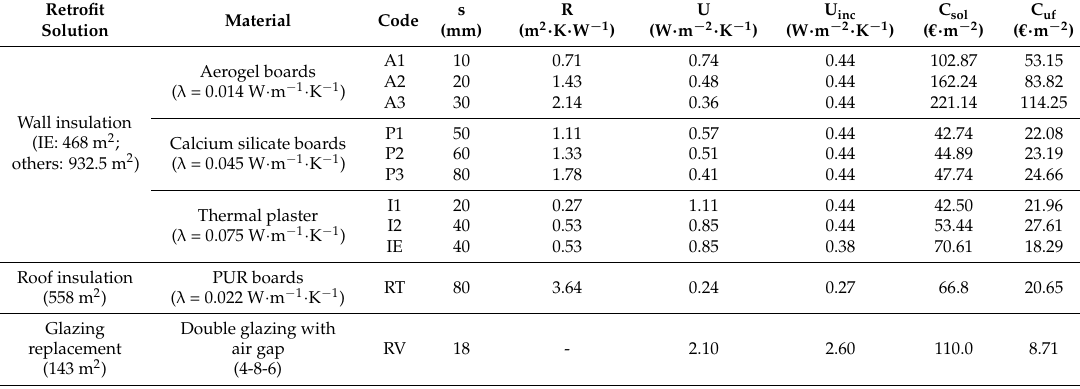
Table 2. Proposed retrofit solutions: thermal properties and unit